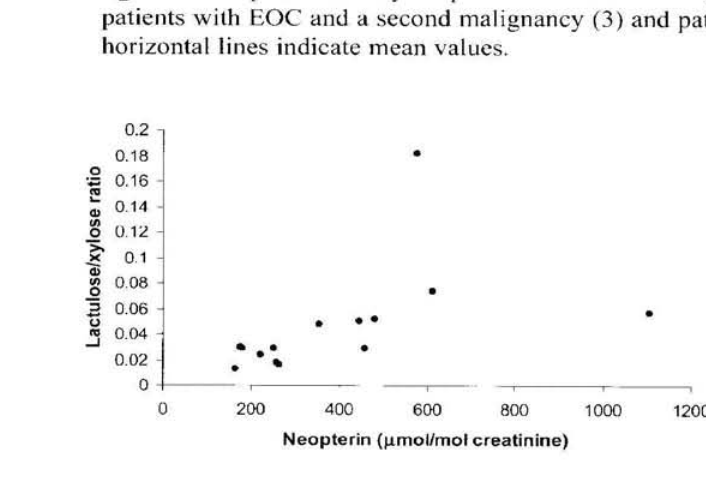
t τ t'gure 2. Dot plot of urinary neopterin measurements in patients with EOC (1), other primary ovarian tumors (2), patients with EOC and a second malignancy (3) and patients with EOC and no history of other malignancy (4); horizontal lines indicate mean values.